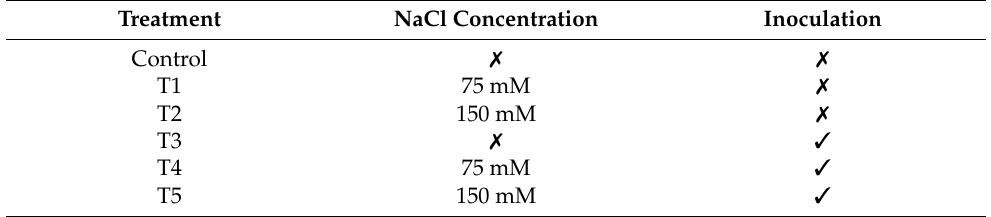
Table 1. Treatment designs of